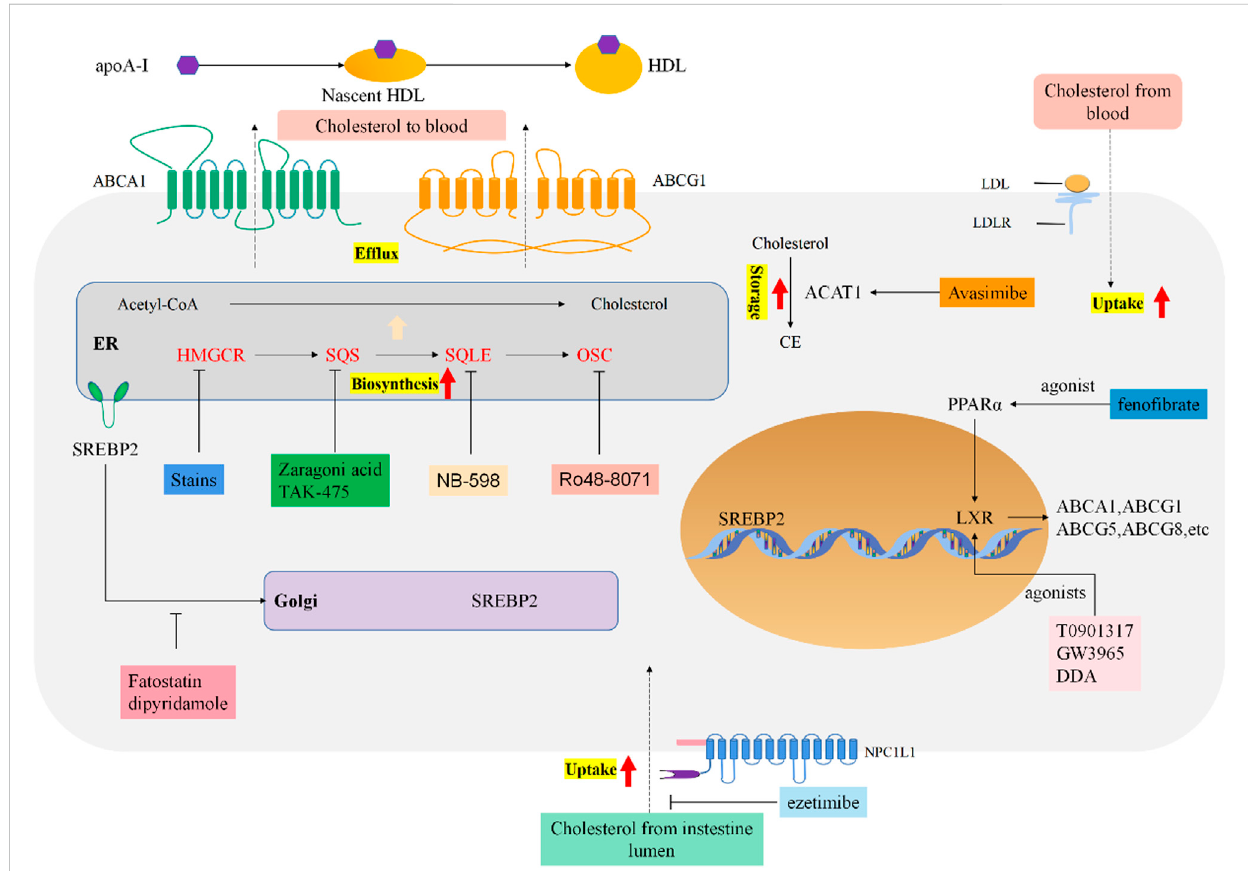
FIGURE 1 Reprogrammed cholesterol metabolism and indicated drug targets in tumor cells. Cholesterol metabolism and homeostasis regulation in cancer cells. Boxes of different colors indicate targeted therapeutic drugs and drug targets for each stage of cholesterol